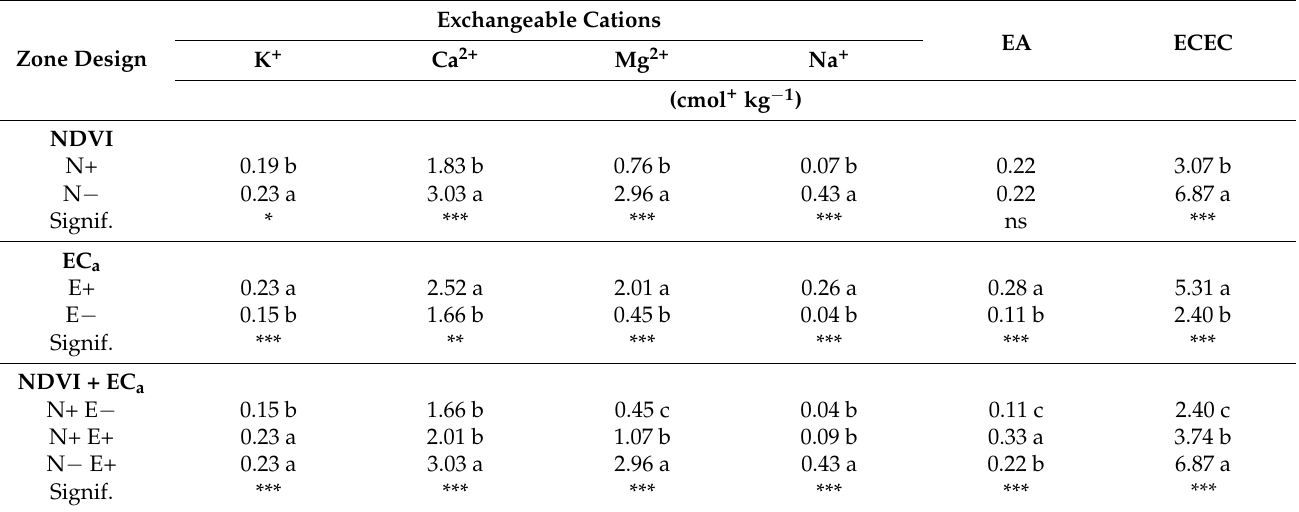
Table 3. Mean values of soil exchangeable cations, exchangeable acidity (EA), and effective cation exchange capacity (ECEC) according to zone and indicator